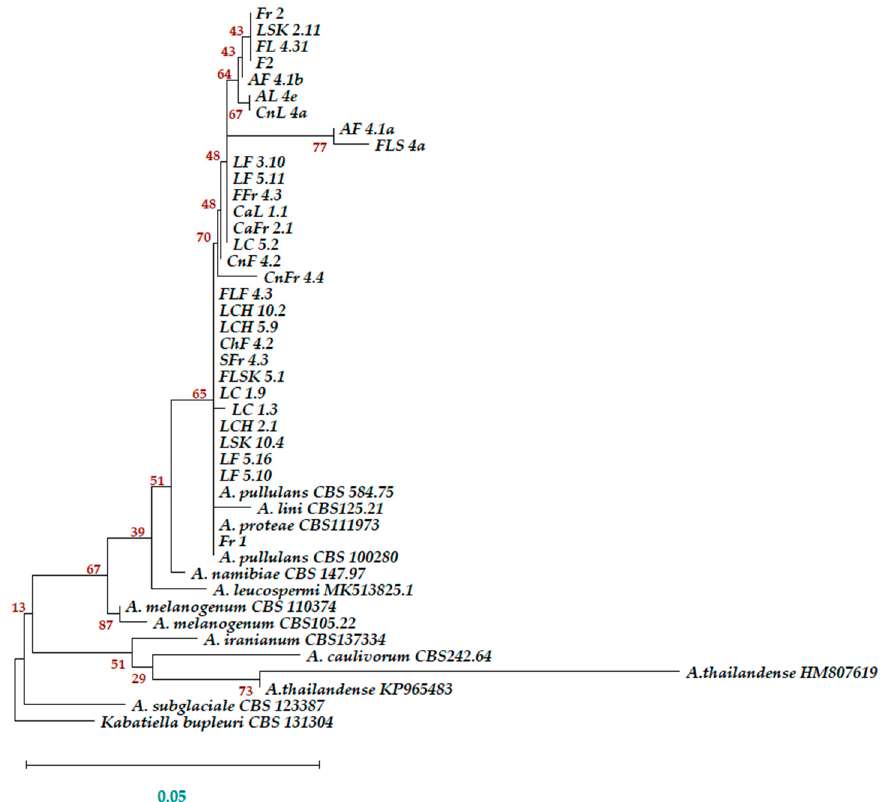
Figure 3. The ITS sequences of the 30 A. pullulans isolates cluster with published A. pullulans , A. proteae , and A. lini ITS sequences. The evolutionary history was inferred by using the Maximum Likelihood method and Tamura–Nei model [35]. The tree with the highest log likelihood ( − 1641.85) is shown. The percentages of trees in which the associated taxa clustered together are shown next to the branches. The initial tree for the heuristic search was obtained automatically by applying the Maximum Parsimony method. A discrete Gamma distribution was used to model evolutionary-rate di ff erences among sites (5 categories ( + G, parameter = 0.2691)). The rate variation model allowed for some sites to be evolutionarily invariable ([ + I], 0.00% sites). The tree is drawn to scale, with branch lengths representing the numbers of substitutions per site. This analysis involved 44 nucleotide sequences. There were a total of 675 positions in the final dataset. Evolutionary analyses were conducted in MEGA X [36] .